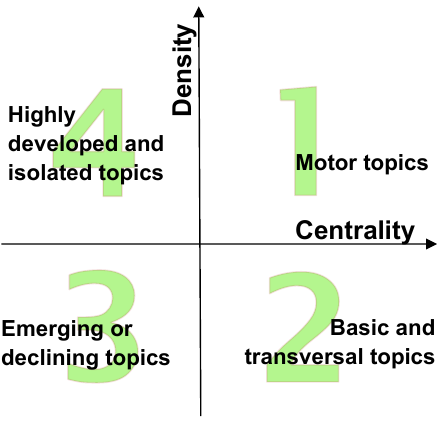
Figure 3. Strategic diagram’s quadrants.